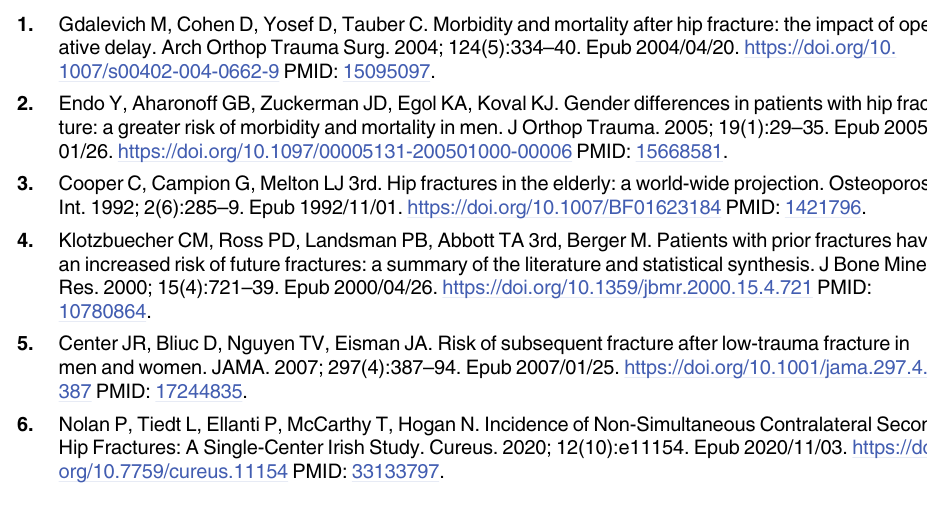
S1 Table. Common Procedural Terminology (CPT) codes used for cohort building. S2 Table. Adjusted associations of exposures and covariates with prescription of anti-oste- oporosis medication inclusive of all covariates. S3 Table. Sensitivity analysis: Adjusted associations of exposures and covariates with pre- scription of anti-osteoporosis medication inclusive of those with unknown